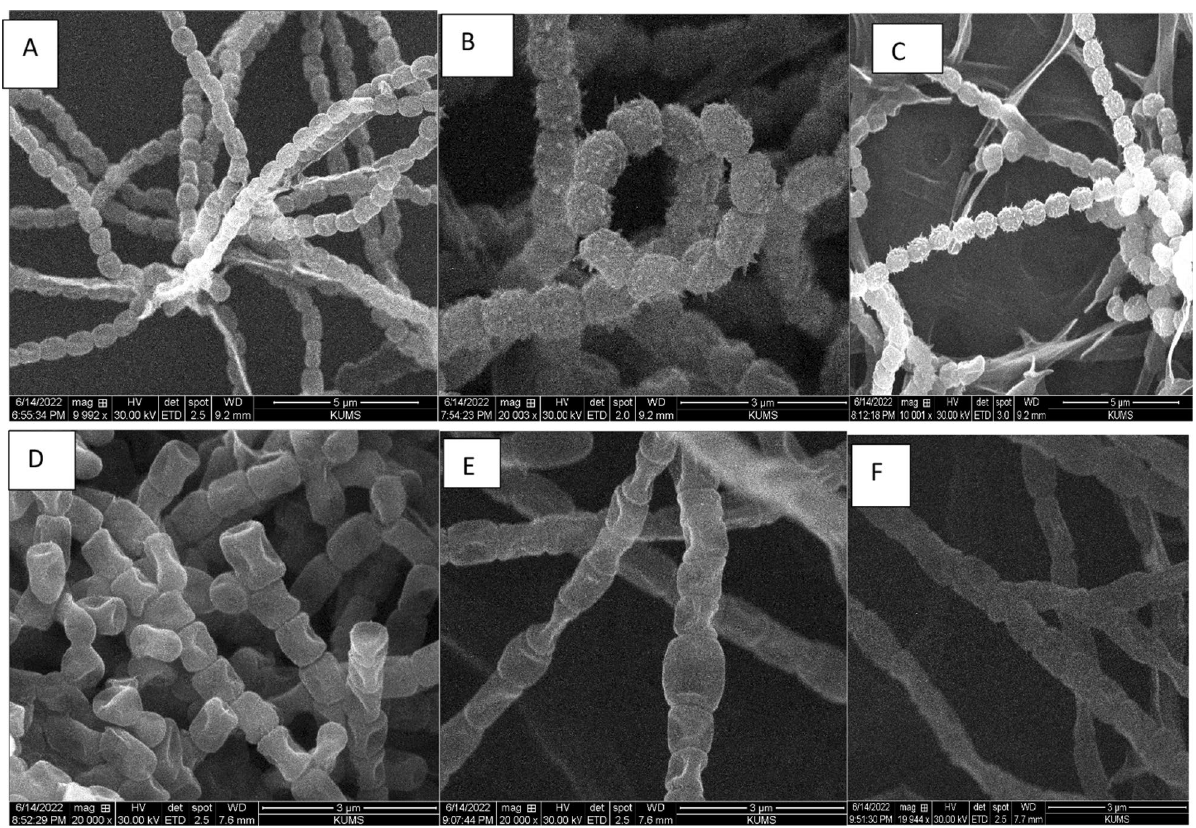
Figure 3. Scanning electron micrograph of mycelia and spores representing the spore-chain morphology and spore-surface ornamentation of strains and mycelia grown on ISP2 medium for 14 days at 28 °C at different magnification. Streptomyces koyangensis KUMS-B1 (oval and ovoid shape with smooth surfaces) ( A ); S. griseorubens KUMS-B2 isolate (flexuous spiral spore chains, oval and ovoid shape with warty, hairy or rough and coarse surfaces) ( B ); S. intermedius KUMS-B3 (straight spore chains, oval and ovoid shape with a warty, spiny or hairy surfaces) ( C ); S. microflavus KUMS-B4 (spores are cylindrical cube-shapes with indenting surfaces, and fragmented) ( D ); S. cavourensis KUMS-B5 (spores have cylindrical shapes with indenting surfaces) ( E ); S. praecox KUMS-B6 (The spores have cylindrical shapes with smooth surfaces) ( F ).